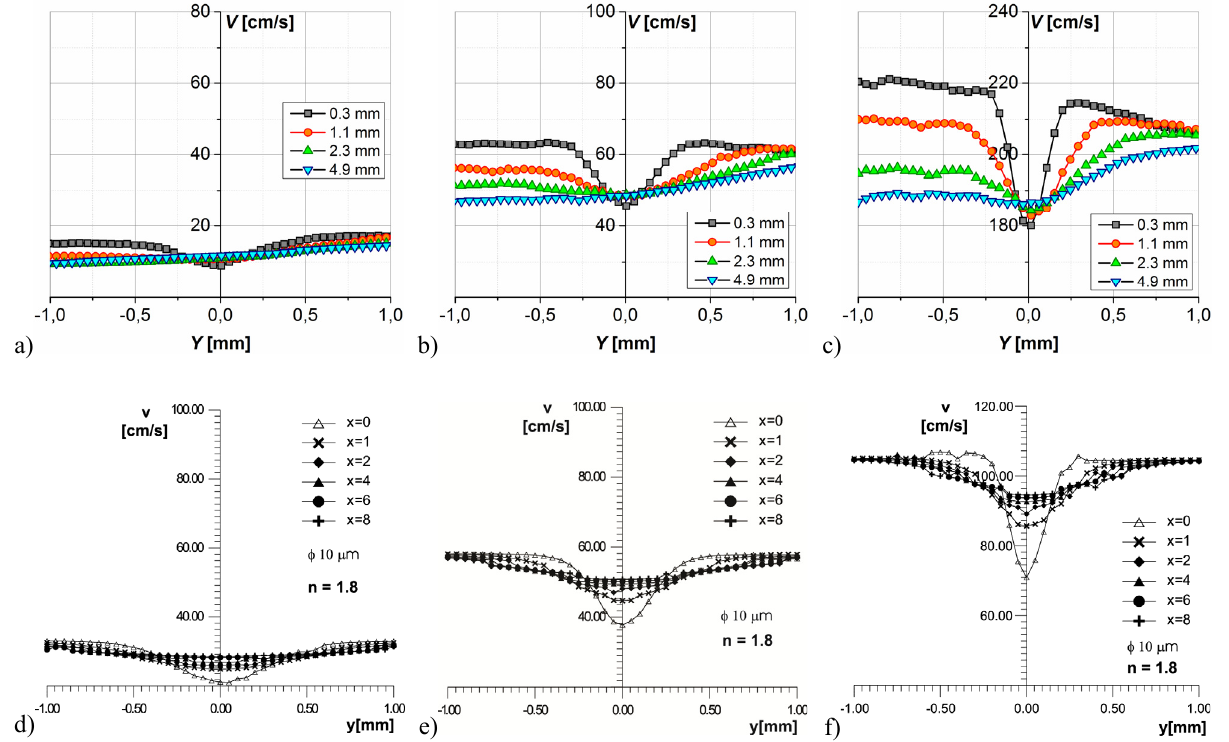
Fig. 6. Transverse velocity profiles of the wake behind the heated wire ( a = 0.8). Results achieved by the author of the present paper – upper row, and by the author of [19] – bottom row. In both cases values in legends define the distances in millimetres between the wire and the